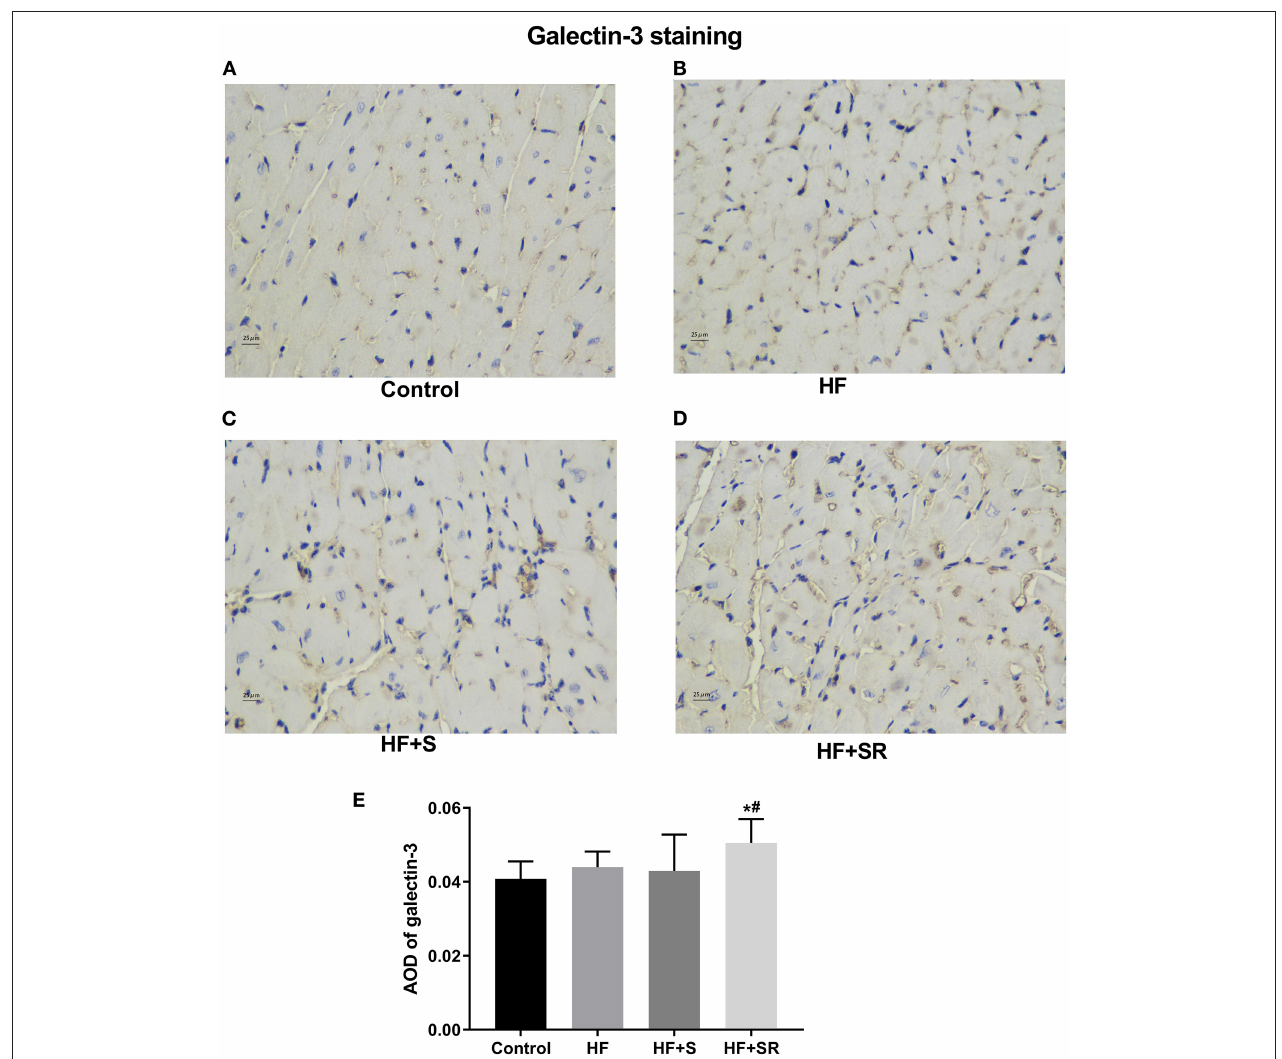
FIGURE 5 | Immunohistochemistry of galectin-3 in heart tissues from different groups. The controls had almost no galectin-3 expression (A) . The HF ( n = 5) and HF + S ( n = 8) mice had some galectin-3 expression (B,C) . The HF + SR mice ( n = 8) showed significantly stronger staining for galectin-3 (D) . Semiquantitative analysis of galectin-3 levels by measuring AOD (E) . * P < 0.05 vs. controls, # P < 0.05 vs. HF